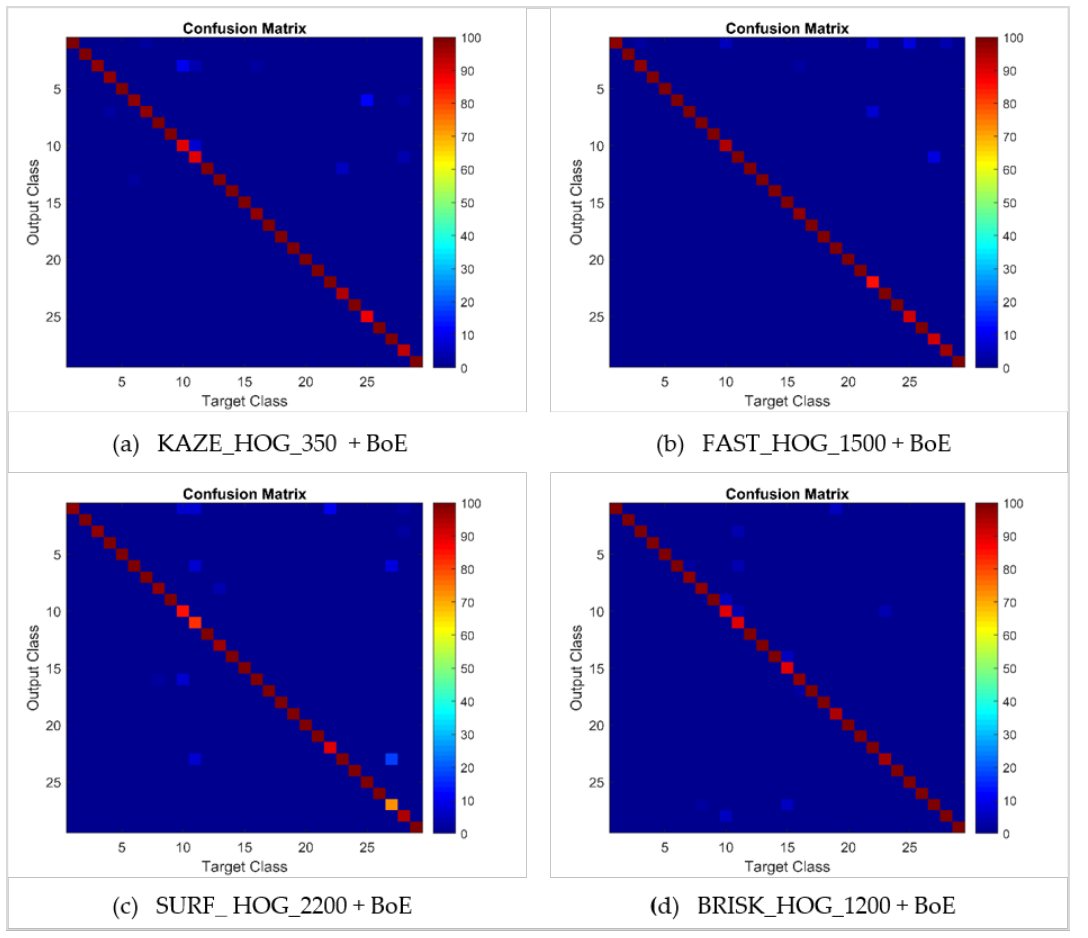
Figure 10. Confusion matrices for bag of expression for the 80–20 NTOU-MMR